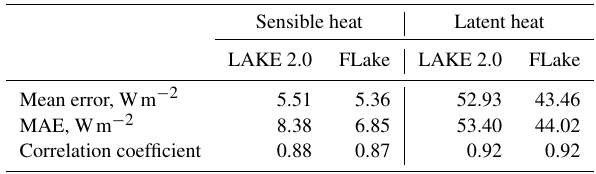
Table 3. Sensible and latent heat flux errors and correlation